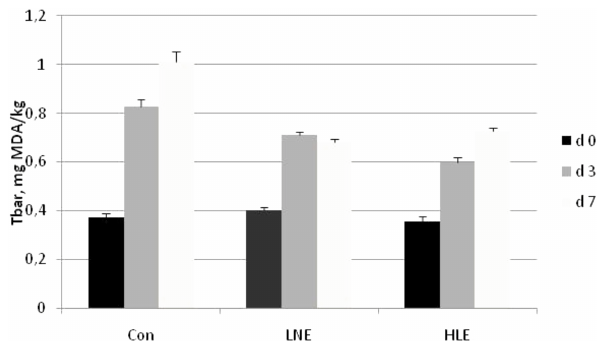
Figure 1. Effect of Lippia citriodora extract on thiobarbituric acid reactive substances (TBARSs) during storage at 4 ◦ C of the Longis- simus lumborum muscle. Groups: control group (CON); low natural extract (LNE); high natural extract (HNE). Time effect: P < 0 . 001; diet effect: P = 0 .